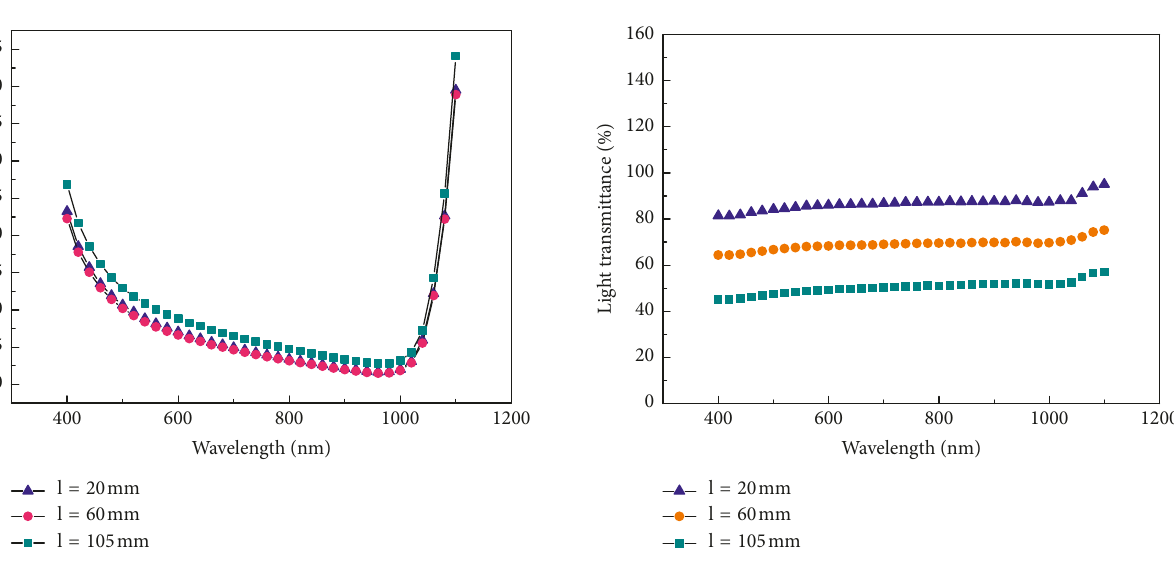
Figure 16: Relationship between the wavelength and incident optical power of specimens with different lengths.